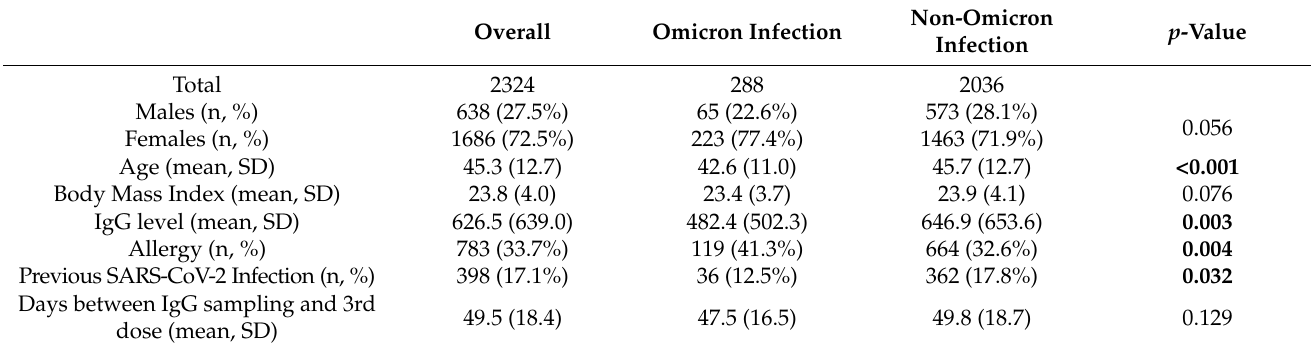
Table 1. Demographic information of the study